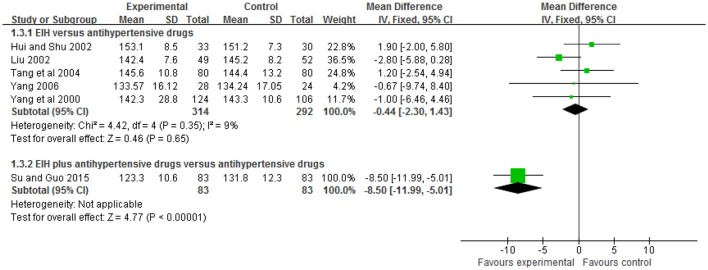
The forest plot of comparison of two groups for the outcome of systolic blood pressure.